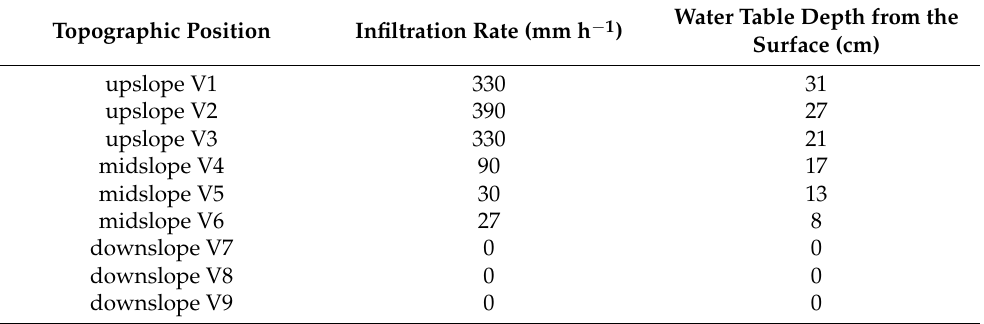
Table 3. Infiltration rate and groundwater table depth measured on 16 August 2018 in the Debre Mawi watershed. Topographic Position